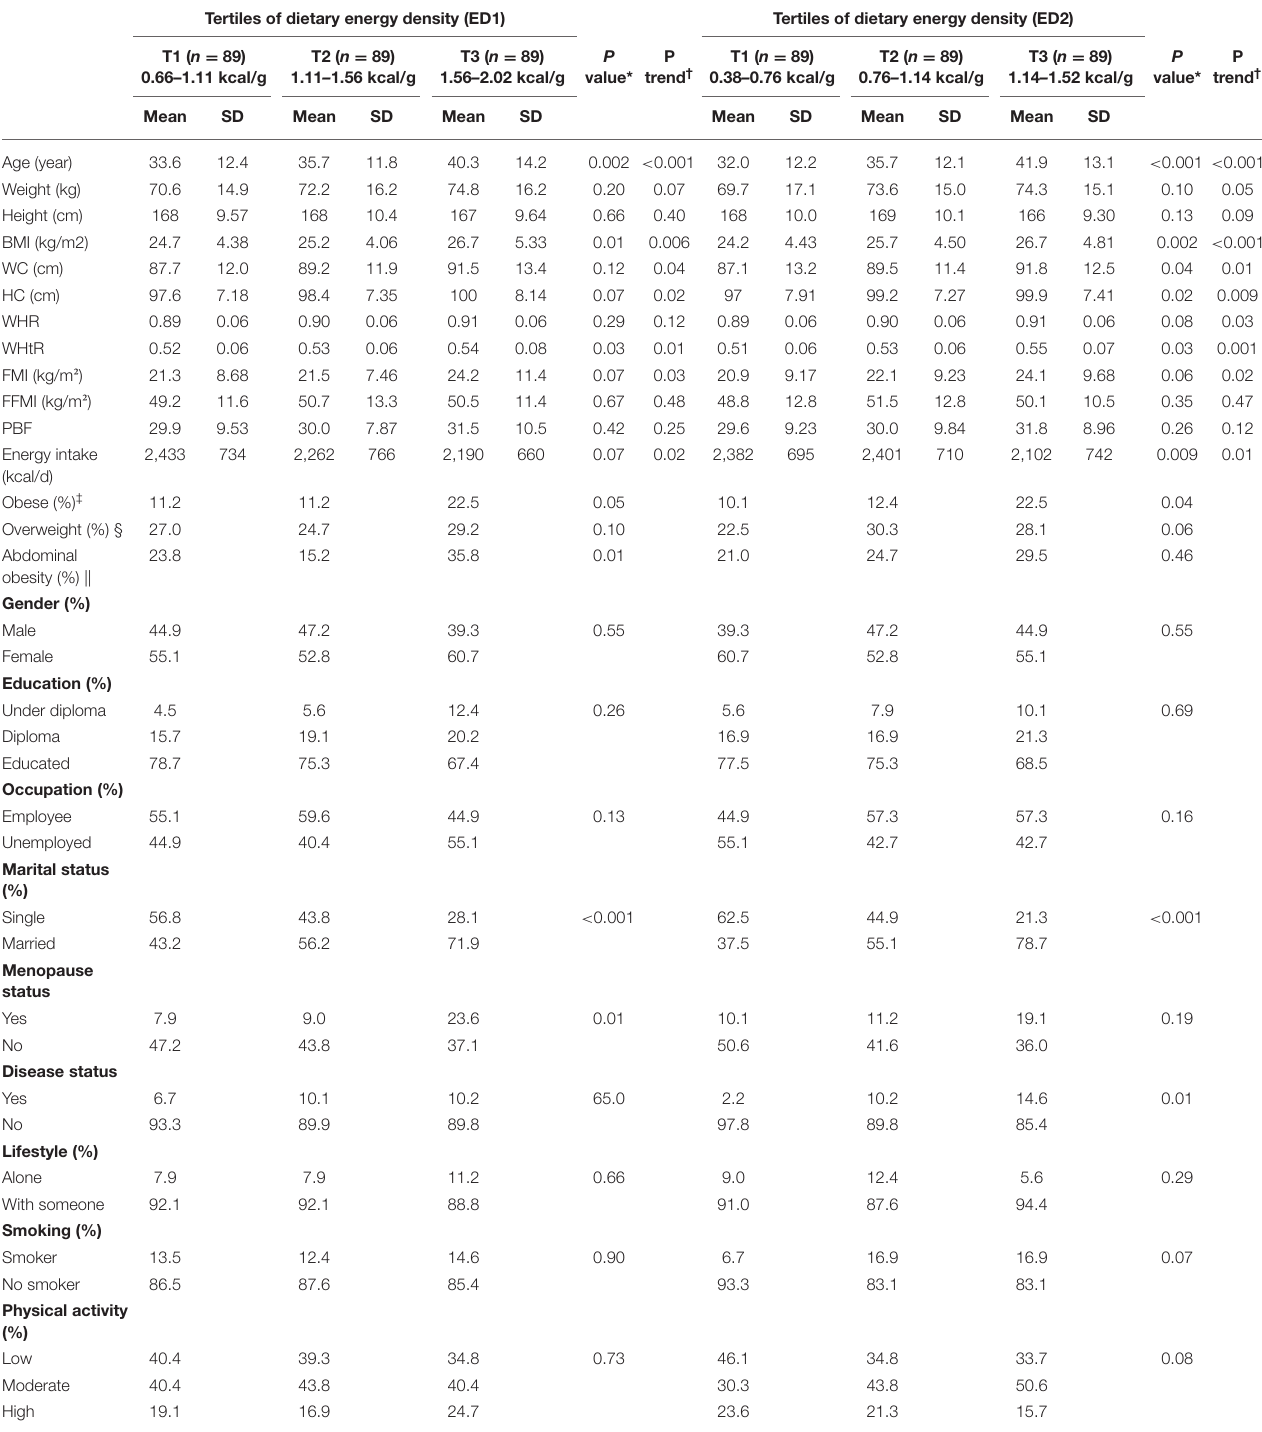
TABLE 1 | General characteristics of participants by tertiles of the dietary energy density (DED) in a sample of Iranian adults. Tertiles of dietary energy density